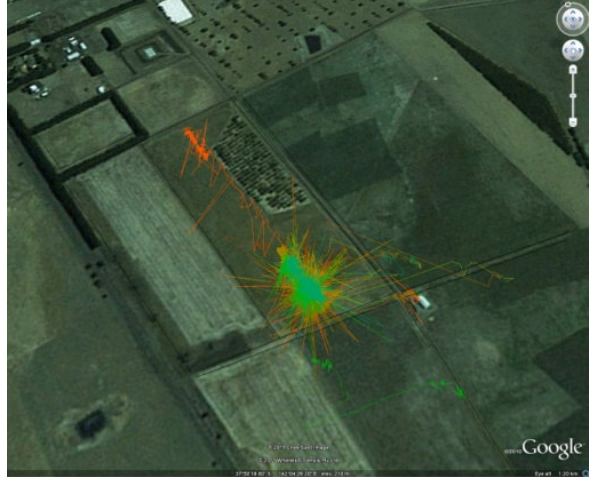
Figure 3. Raw data for sheep positions over time in a 14 ha paddock using GPS collars and Google Earth as context. Each colour corresponds to an animal and location.